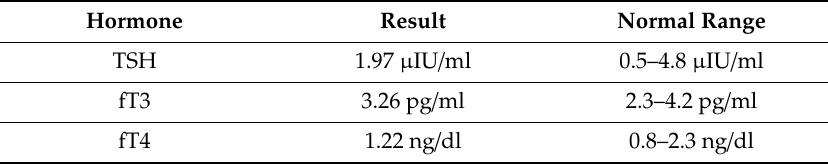
Table 5. Concentrations of chosen hormones in the described patient.